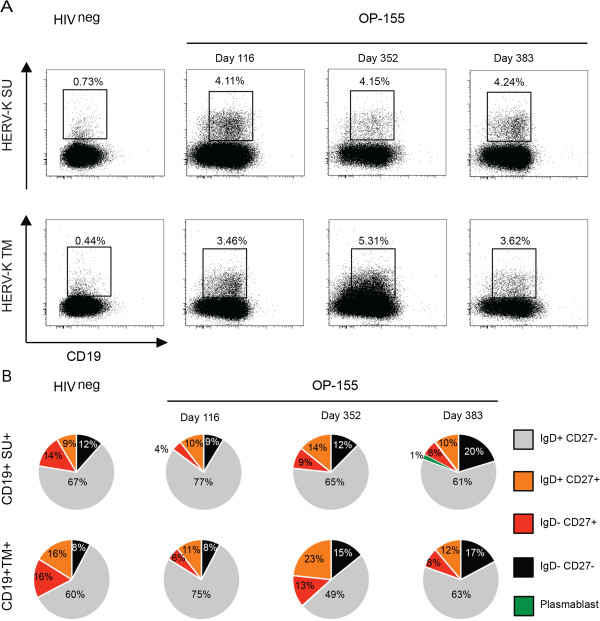
Anti-HERV-K (HML-2) TM and SU specific B-cell responses. A) The presence of HERV-K specific B-cells was detected at three time points from the same patient OP-115. CD19+ gated plots show the double population CD19 + tetramer + and the graphics represent the specific B-cells sub-populations. B) The study of the B-cell subset was based on CD27 and IgD extracellular expression. Memory cells (CD27+) were identified by their IgD expression; CD27+ IgD+: unswitched memory; CD27+ IgD-: switched memory. A Plasmablast is defined by the absence of IgD expression and a high expression of CD27.